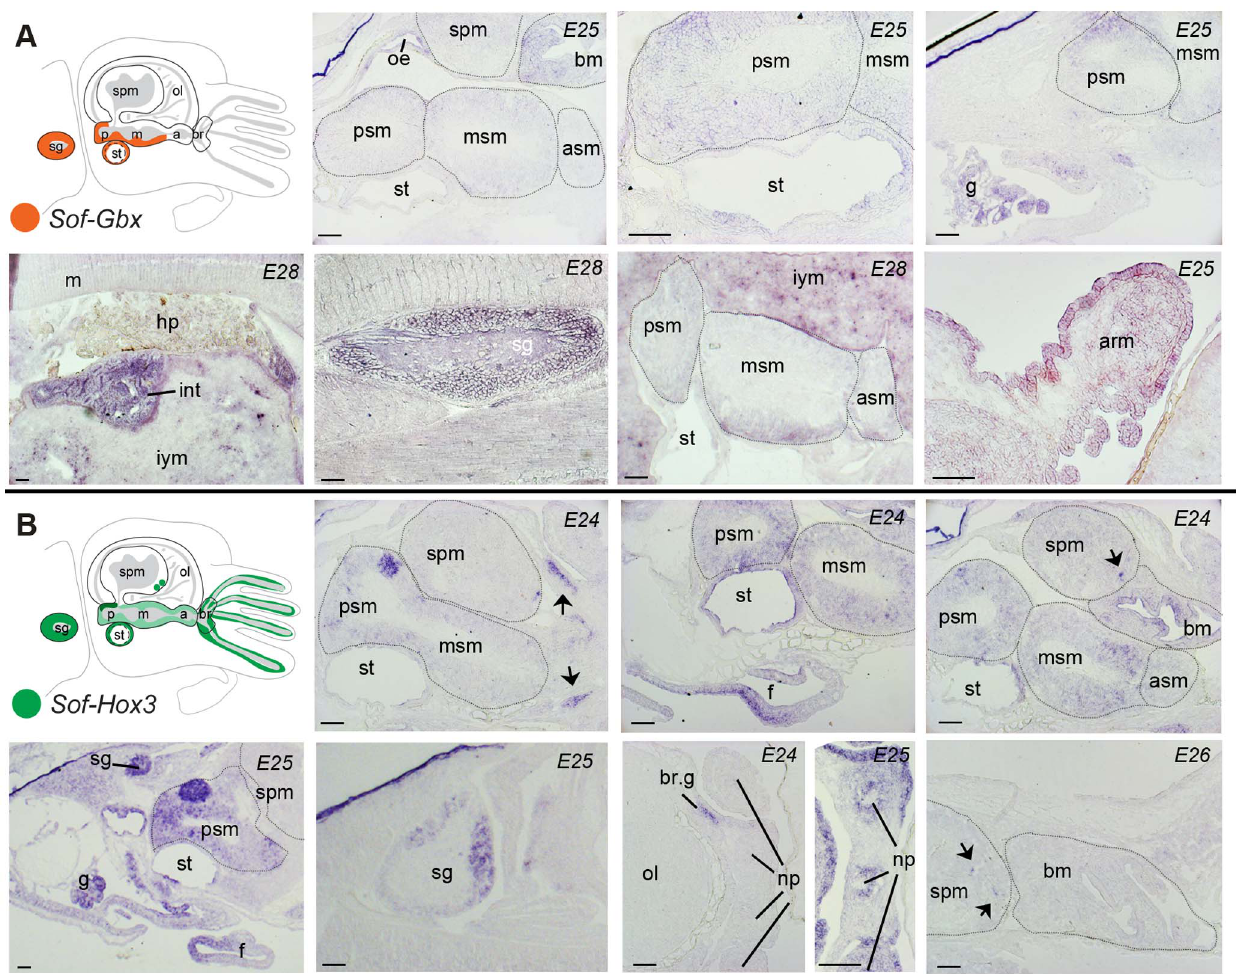
Figure 4. Spatial gene expression profiles of ANTP-class homeodomain genes. Figure layout as in Figure 3. A) Sof-Gbx . Clockwise from upper left: Medial section through the head showing signal within the buccal mass, oesophagus, and posterior and middle subesophageal masses; Higher magnification from the same embryos showing gene signal within the posterior subesophageal mass and statocyst; Media-lateral section through the mantle cavity highlighting expression in the gills and posterior subesophageal mass; Expression is detected in the arm epithelium; Medial section of the subesophageal mass, signal is evident in the ventral-most regions; Staining of the stellate ganglion; Medial section through the mantle cavity highlighting gene expression in the intestinal apparatus. B) Sof-Hox3 . Clockwise from upper left panel; Medial section through the head showing extensive staining within the posterior and middle subesophageal masses, highlighting a domain of concentrated gene expression posteriorly. Signal is also present at the level of the brachial ganglia (arrows); Section showing medial staining within the funnel; Section shows staining in the beak epithelium in the buccal mass and a small population of 2–4 cells (arrow) in the anterior-most portion of the supraesophageal mass; Buccal mass staining is no longer present by stage E26, whereas the supraesophageal mass cells retain expression (arrows); Section through the base of the arms in a stage E25 embryo shows staining within the arm epithelium and the nerve cord surrounding the neuropil of the arms (np); Similar staining within the arms is not present in earlier stage E24 embryos, while expression in the brachial ganglia primordial is present; Abdominal section showing staining in the stellate ganglia; Lower magnification image showing staining in gills, stellate ganglia, subesophageal mass, and ventral-most portion of the funnel tube. Abbreviations - br.g: brachial ganglia; g: gills; hp: hepatopancreas; int: intestine; iym: inner yolk mass; m: mantle; np: neuropil; oe: oesophagus; all others as in Figure 3.